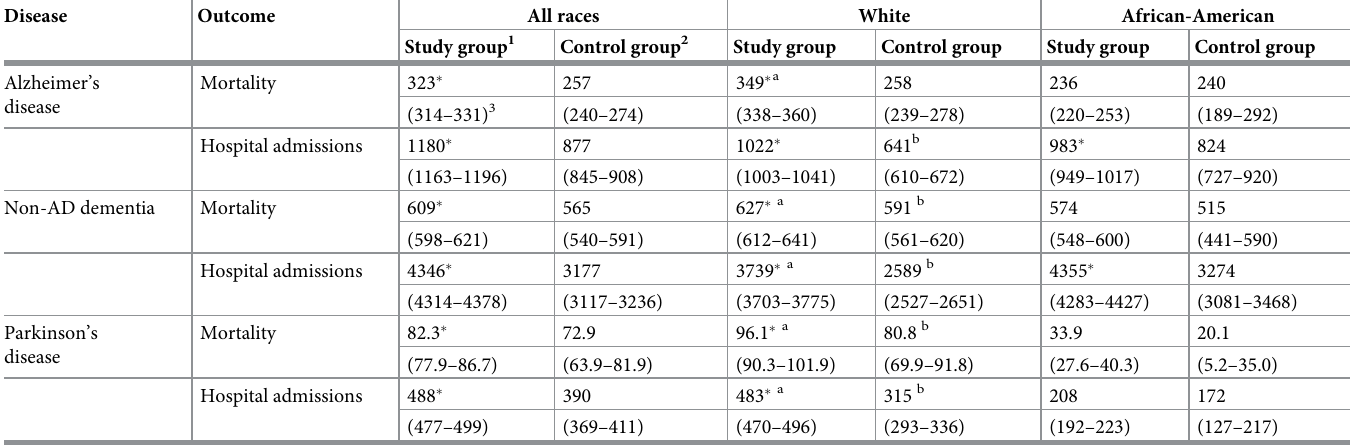
Table 2. Age-adjusted rates of mortality and hospital admissions in the study and Control groups per 100,000: Race-specific analysis, underlying causes of death/ primary diagnoses. Disease